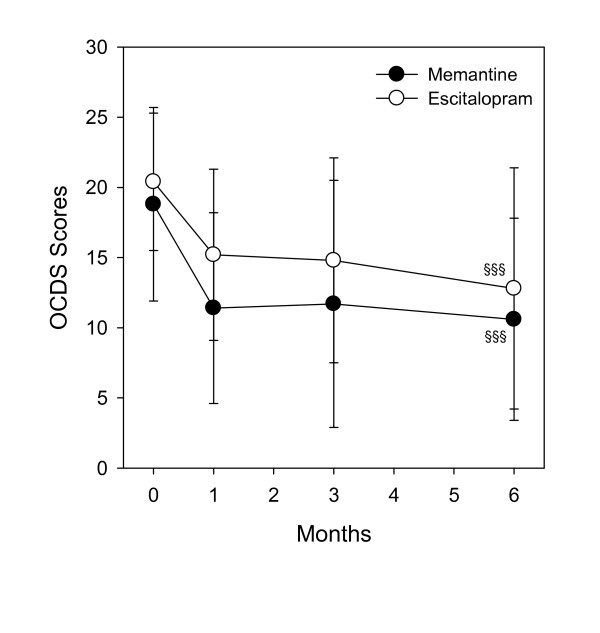
Change in alcohol graving measured by the OCDS scores. §§§significant reduction from base values prior to treatment, p < .0001, ± SD.